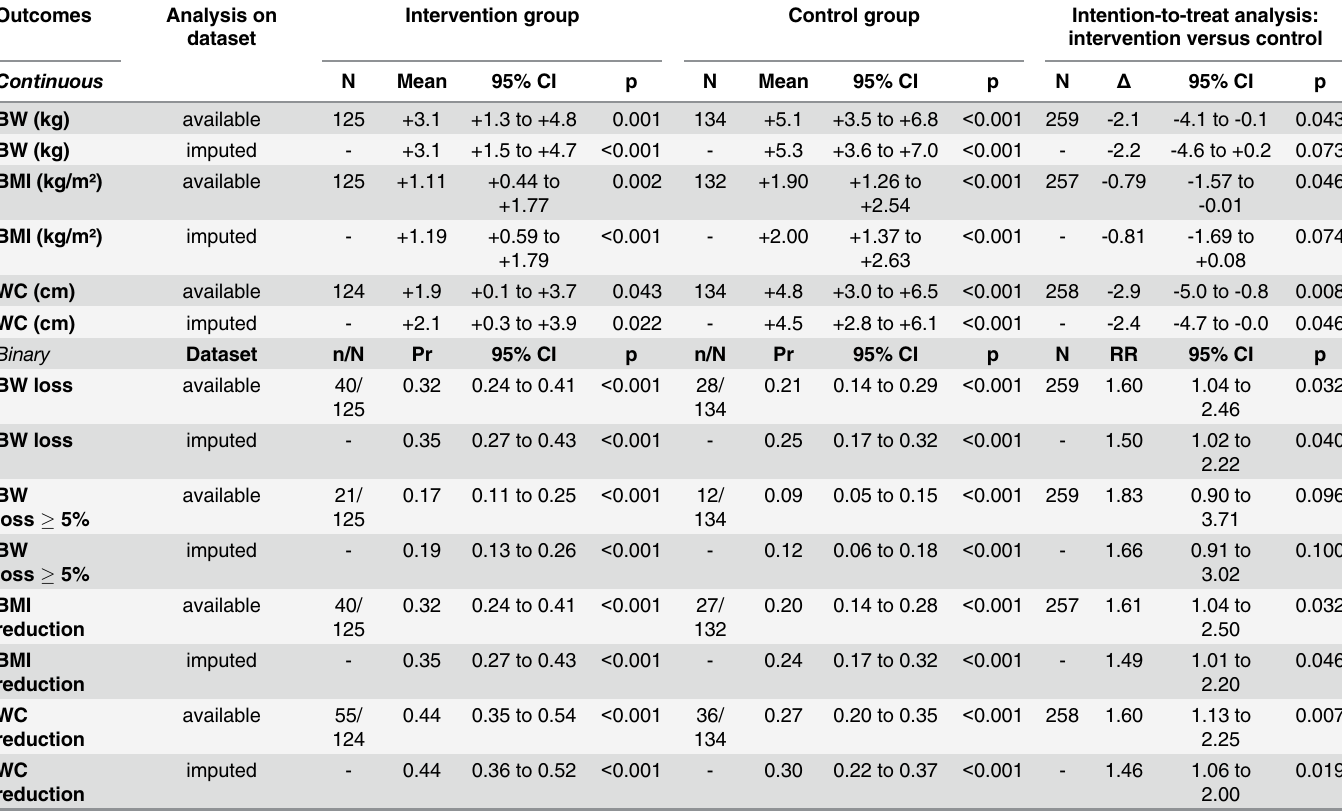
Table 4. Nine-year changes in body weight (BW), body mass index (BMI) and waist circumference (WC): adjusted estimates (mean, Δ , RR). Outcomes Analysis on Intervention group Control dataset